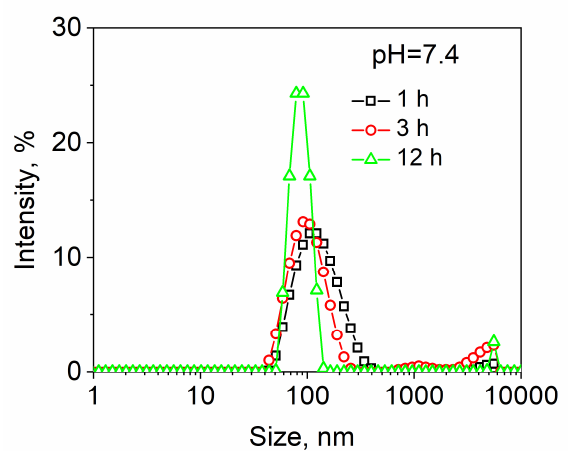
Figure 3. The hydrodynamic sizes of PMOXA 14 -PDMS 65 -PMOXA 14 vesicles in the buffer solution at pH = 7.4 and 37 °C.